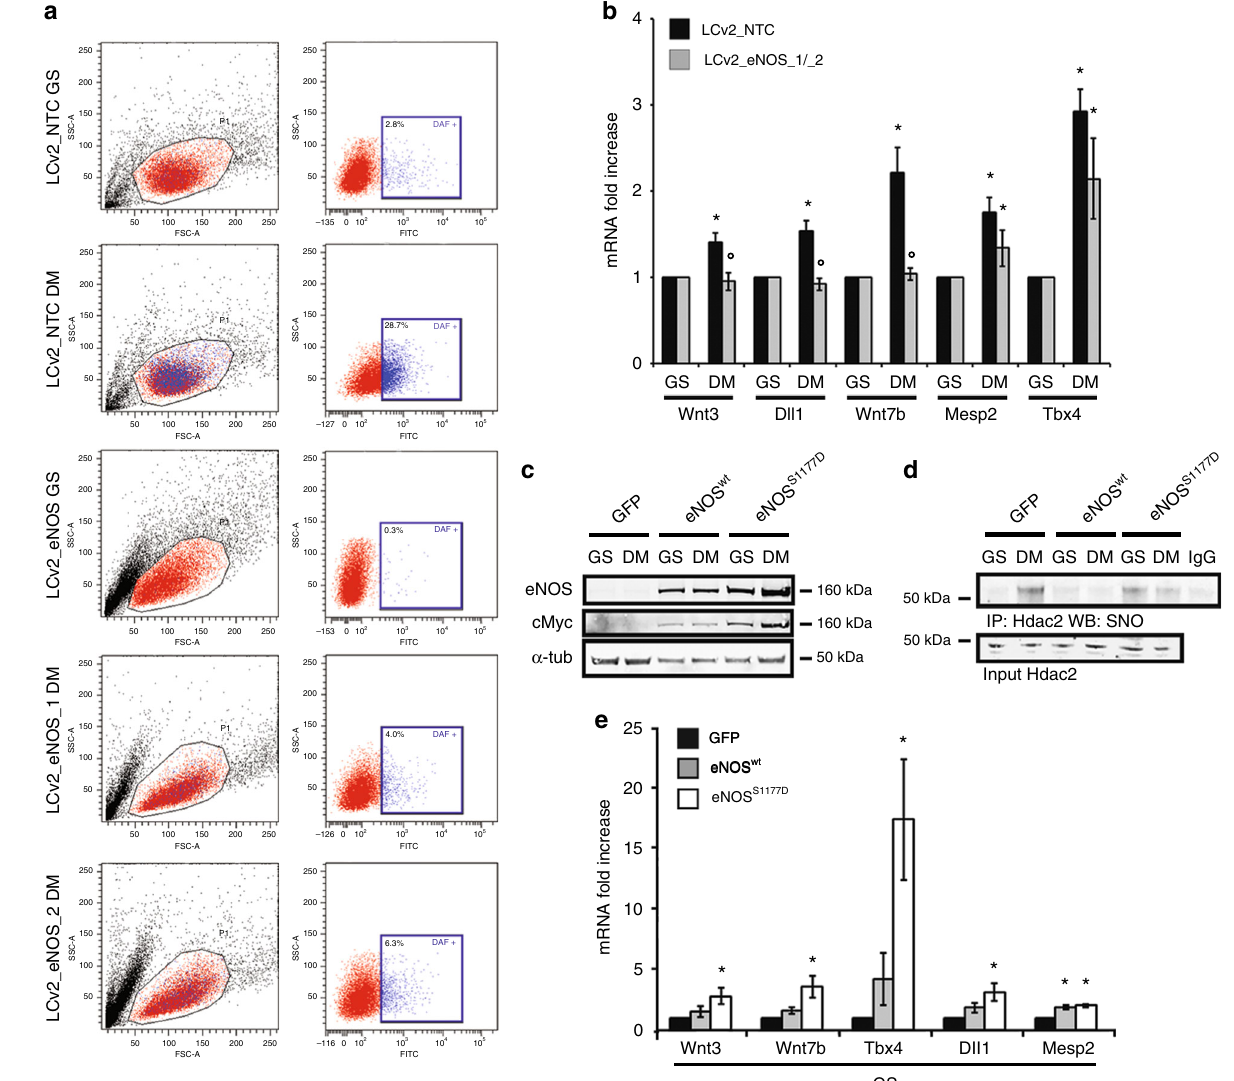
Fig. 5 Role of eNOS during mesendodermal commitment. a Fluorescence activated cell sorter analysis of mESC cultured in GS and 2 h in DM prior (control vector LCv2_NTC) and after CRISPR/Cas9 inactivation of eNOS (LCv2_eNOS_1 or LCv2_eNOS_2). Left cytograms: representative scatter plots showing the forward (FSC-A) and side scatter (SSC-A) distribution of the mESC population. Right panels: representative dot plot showing the fl uorescein isothiocyanate (FITC) and SSC-A distribution of the mESC population in the presence of DAF fl uorescent probe. b qRT-PCR analysis of mRNA expression relative to Wnt3, Dll1, Wnt7b, Mesp2, and Tbx4 transcripts in mESC cultured for 24 h in GS and DM prior (control vector LCv2_NTC; black bar) and after CRISPR/Cas9 inactivation of eNOS (LCv2_eNOS_1/_2; gray bars). Data are shown as the mean of three independent experiments for each CRISPR/Cas9 vector ± s.e.m. represented as fold increase compared to control mESC after subtraction of the housekeeping gene p0 signal (* p < 0.05 DM vs. GS; ° p < 0.05 LCv2_eNOS_1/_2 vs. LCv2_NTC). c Representative western blot performed with cell extracts obtained from mESC infected by Ad_GFP, Ad_eNOS wt , or Ad_eNOS S1177D cultured for 24 h in GS or DM ( n = 3 each group). The expression of eNOS and cMyc was evaluated. The signal from α - tubulin antibody was used as loading control. Full-length blot provided in Supplementary Fig. 10a. d Representative immunoprecipitation (IP) western blotting (WB) analysis of Hdac2 S-nitrosylation performed in mESC infected by Ad_GFP, Ad_eNOS wt , or Ad_eNOS S1177D cultured in GS or after 2 h from release into DM ( n = 3 each group). Full-length blot provided in Supplementary Fig. 10b. e qRT-PCR analysis of mRNA expression relative to Wnt3, Wnt7b, Tbx4, Dll1 and Mesp2 transcripts in mESC cultured for 24 h in GS prior (control Adeno virus Ad_GFP; black bar) and after infection by Ad_eNOS wt (gray bars) or Ad_eNOS S1177D expressing the constitutive active eNOS (white bars). Data shown as the mean of three independent experiments±s.e.m. represented as fold increase compared to Ad-GFP infected mESC after subtraction of the housekeeping gene p0 signal (* p <0.05 vs. Ad_GFP). Data analyzed by Kolmogorov – Smirnov